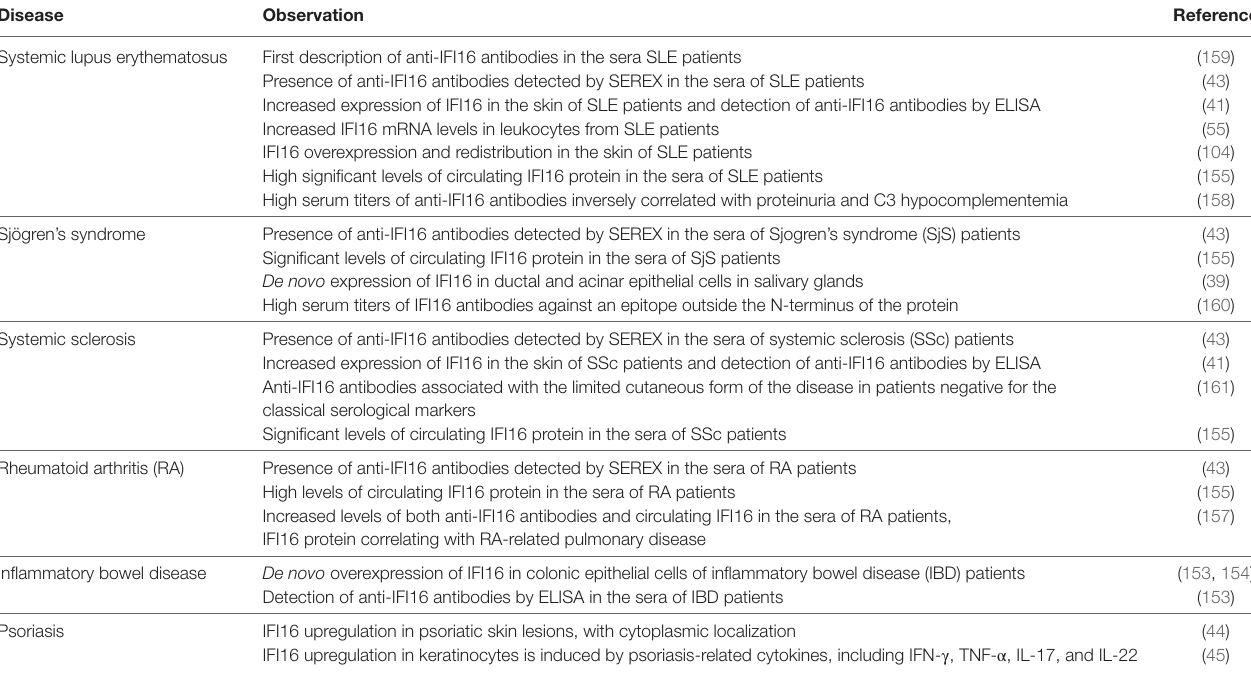
TAbLe 1 | Summary of IFN-inducible protein 16 (IFI16) correlations with systemic lupus erythematosus (SLE) and other autoimmune diseases.